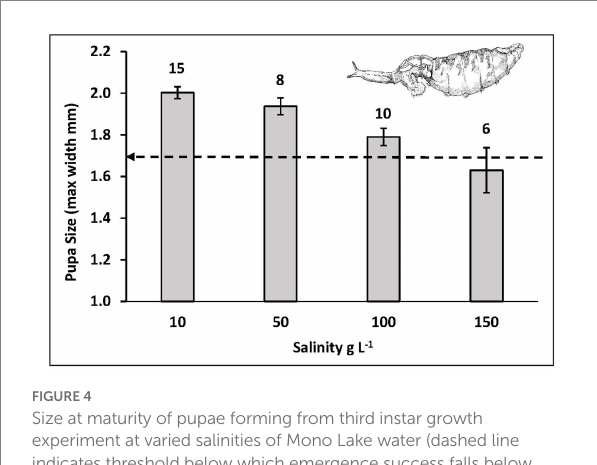
FIGURE 4 Size at maturity of pupae forming from third instar growth experiment at varied salinities of Mono Lake water (dashed line indicates threshold below which emergence success falls below 50%, in Figure 5). Standard error and sample size as in Figure 3 above each bar.